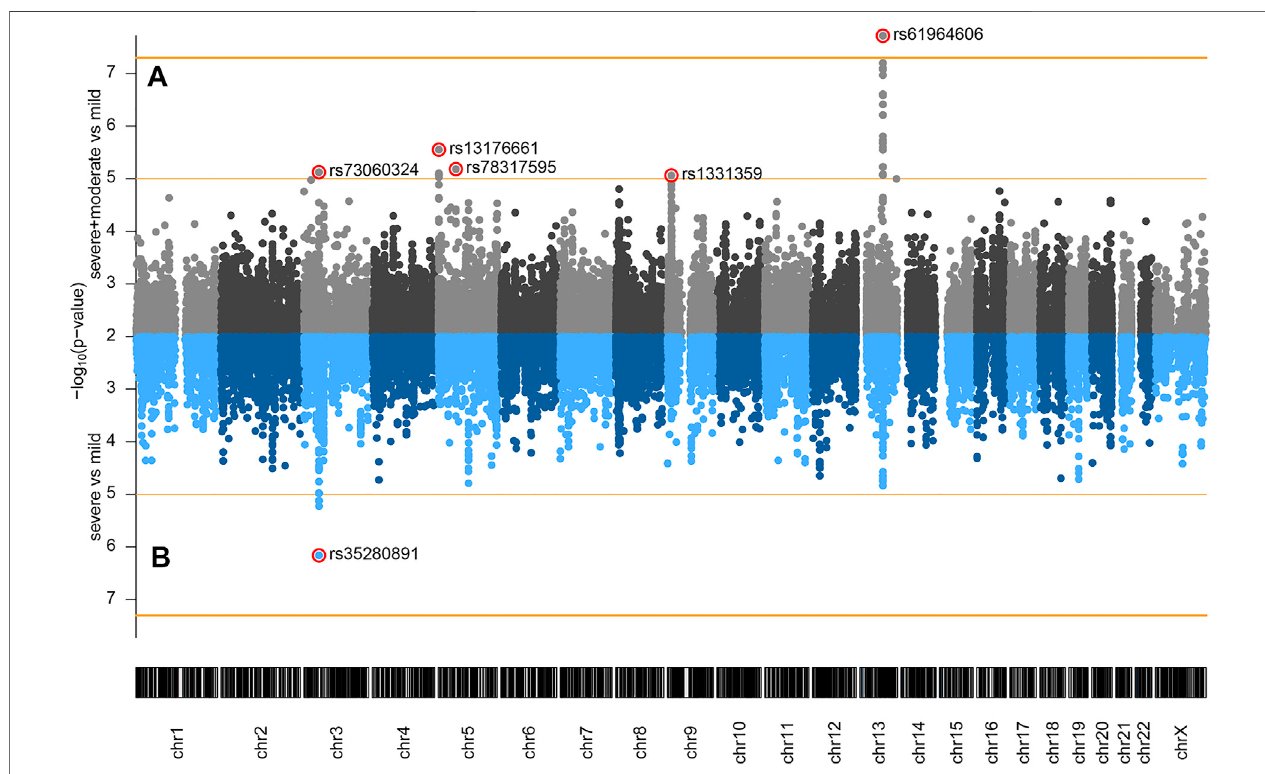
FIGURE 1 | Genome-wide association of COVID-19 outcomes in Serbian population: (A) severe and moderate ( n = 80) versus mild ( n = 48); (B) severe ( n = 34) versusmild ( n =48)comparisons.Genomic coordinates ofanalyzed SNPs aredisplayed alongthe x -axis andtheobservedstatisticalsigni fi canceofassociationwiththe disease outcome on the negative log 10 scale isdisplayed onthe y -axis. SNPs with p < 0.01 are not shown on the plot. The twohorizontalorange lines represent thetwo signi fi cance thresholds used: genome-wide signi fi cance ( p < 5 × 10 − 8 , y ≈ 7.3) and suggestive association ( p < 1 × 10 − 5 , y = 5).